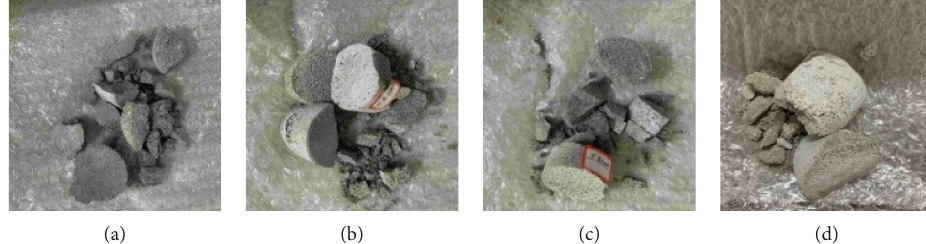
Figure 5: Damage form of 4mm specimens under impact velocity V